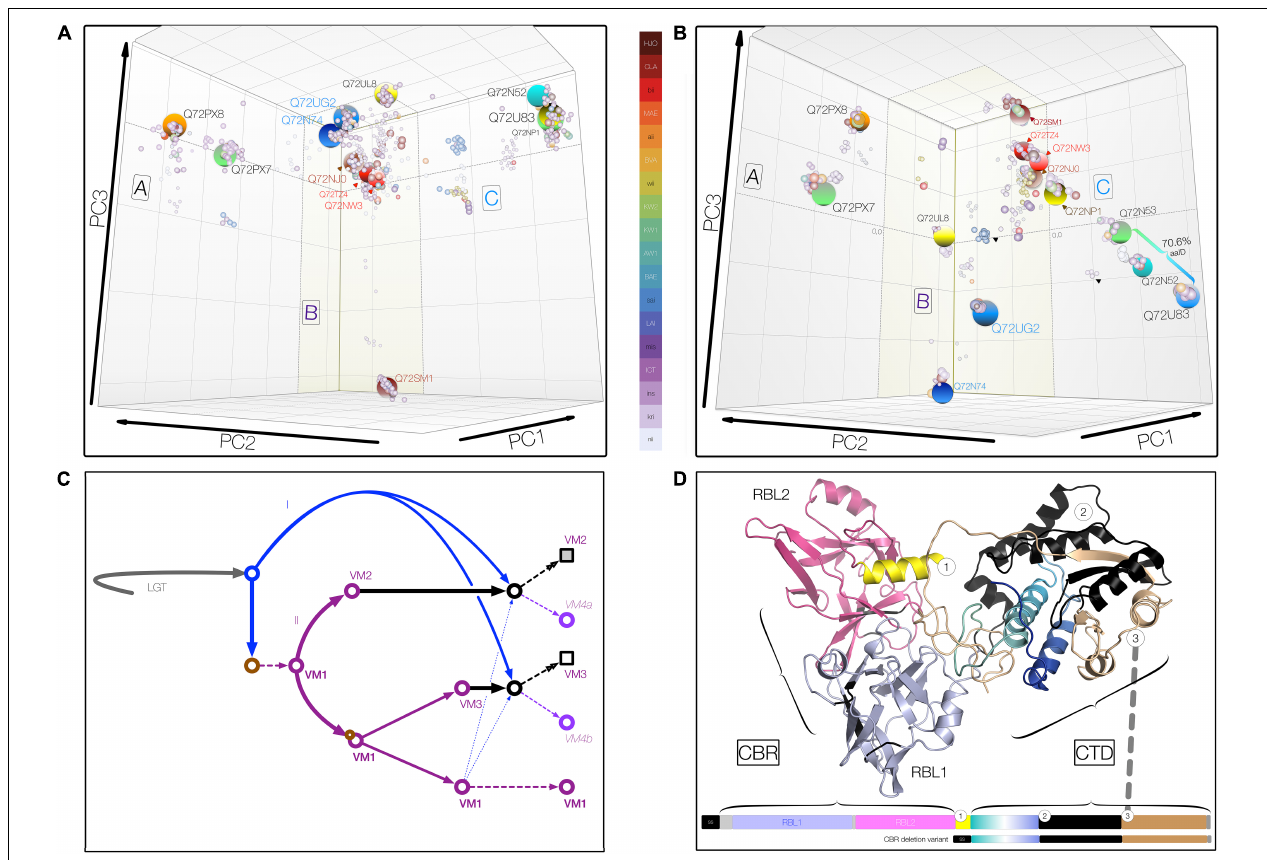
FIGURE 2 | Three-dimensional metric multidimensional scaling (3DMMDS/Galaxy) plots depicting (orthologous) VM protein clusters. Clusters were identified among 940 PF07598 family VM proteins analyzed using bios2mds (Pele et al., 2012) and visualized using principal component analysis in R. In addition to typical PF07598 paralogs, 42 natural deletion mutants lacking both ricin B-like lectin, RBL, subdomains (i.e., containing amino terminal signal sequence and toxin domain only) were included. (A) Carbohydrate-binding region (CBR), containing two unidentical tandem RBL subdomains. (B) Carboxy terminal toxin domain (CTD) encompassing discrete trafficking and DNase subdomains. For both, initial renderings were edited (cosmetic changes only) to aid visualization by enhancing the 3D effect. No coordinates were altered. Clusters containing VM protein variants found in Leptospira interrogans are highlighted (large spheres) and named using the reference L. interrogans serovar Copenhageni strain (PMID 15028702), L1-130 (UniProtKB) protein IDs. Orthologous clusters were grouped into three superclusters comprising VM protein paralogs (A, n = 2; B, n = 7; and C, n = 4) based upon percent identity (PID) ( Supplementary Tables 1–4 ). The color key uses the following convention: for species, L. interrogans (ins), L. kirschneri (kri), L. noguchii (nii), etc.; for serovar, e.g., Canicola (CLA), Lai (LAI), Hardjo (HJO), etc.; and for strains originating from Sri Lanka, e.g., L. interrogans serovar Unknown strain KW1 (KW1), etc. (C) Schematic showing a theoretical evolutionary history of the VM protein family, involving lateral transfer (LGT), gene duplication (purple arrows, II) and erosion (solid black arrows), and recombination (blue arrows = donor acquired via lateral gene transfer, I; broken arrows indicate intragenomic donor from closely related paralog). Circles represent theoretical evolving VM proteins over time; squares represent final evolved form at the current time. (D) Domain organization and junctions of chimeric Leptospira VM proteins resulting from CBR and CTD domain fusions of paralogs belonging to closely related CBR clusters, such as those related to Q72NW3 (e.g., WP.017856587.1) and Q72TZ4 (e.g., QHH71994.1) ( ∼ 99.1% PID, Supplementary Tables 1, 4 ). These natural VM protein variants occur infrequently ( ∼ 2%) in L. interrogans and its sister species, L. kirschneri and L. noguchii. Chimeric VM proteins generally share a common junction regardless of the paralogs